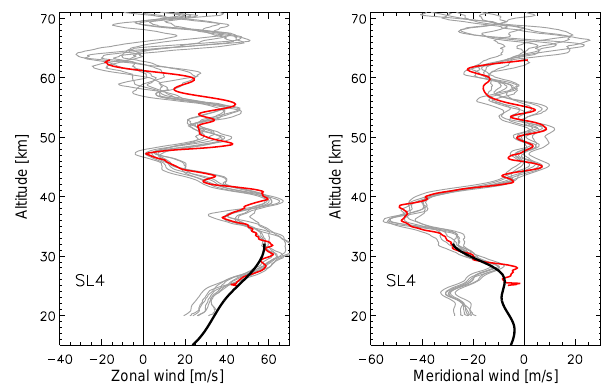
Figure 8. Repeatability of winds measured by DoRIS: all DoRIS profiles within a time period of ± 30min around datasonde flight SL6; difference between the individual profiles and a heavily smoothed profile. Left: zonal winds, right: meridional winds.